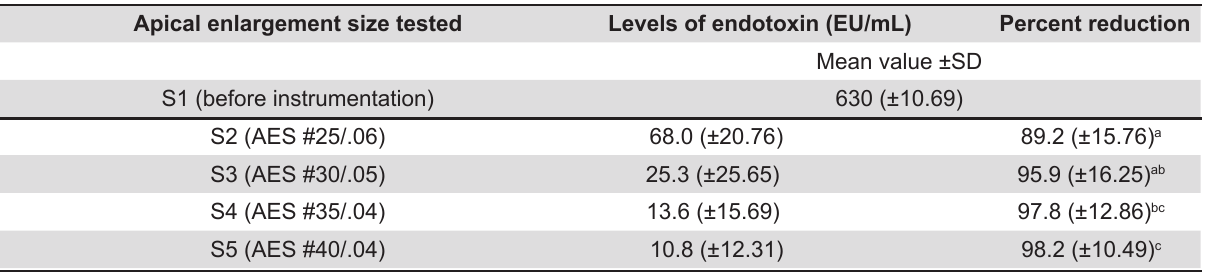
Table 2- Mean and standard deviation (±SD) values of the levels of endotoxin reduced by different apical preparations size tested of Mtwo ® rotary